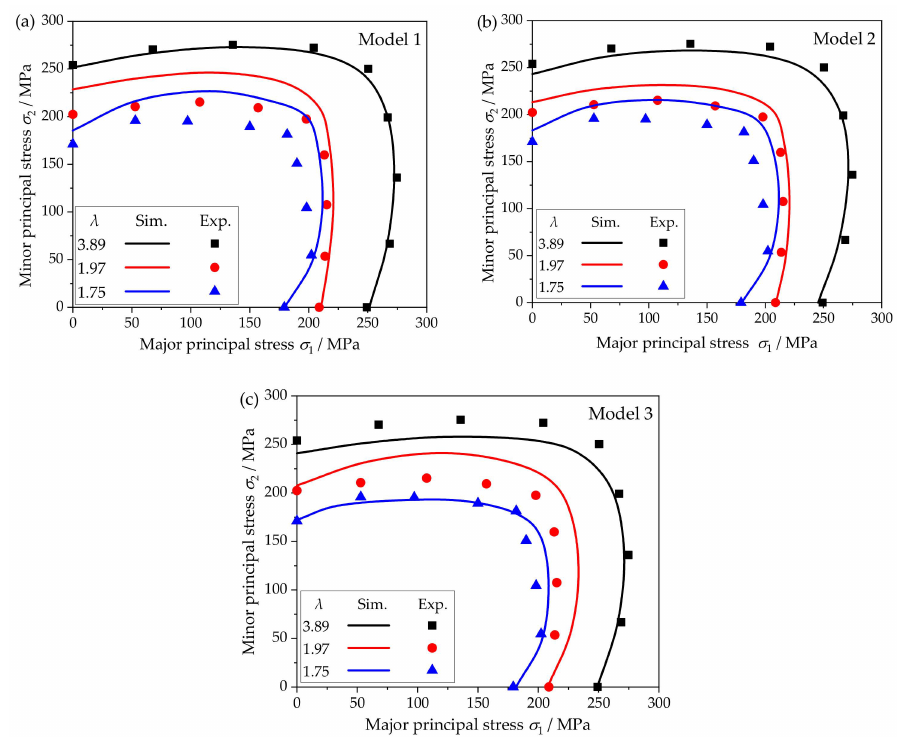
Figure 8. Comparison of simulated and experimental yield loci in different models: ( a ) model 1;